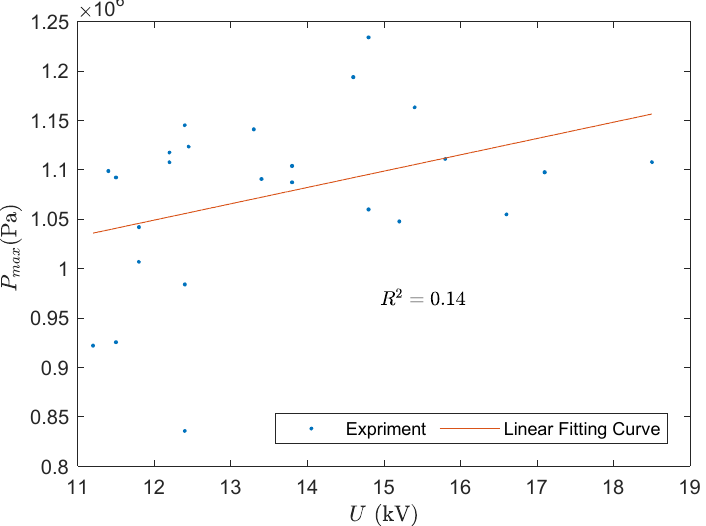
Figure 10. The relationship between the breakdown voltage and maximum pressure.